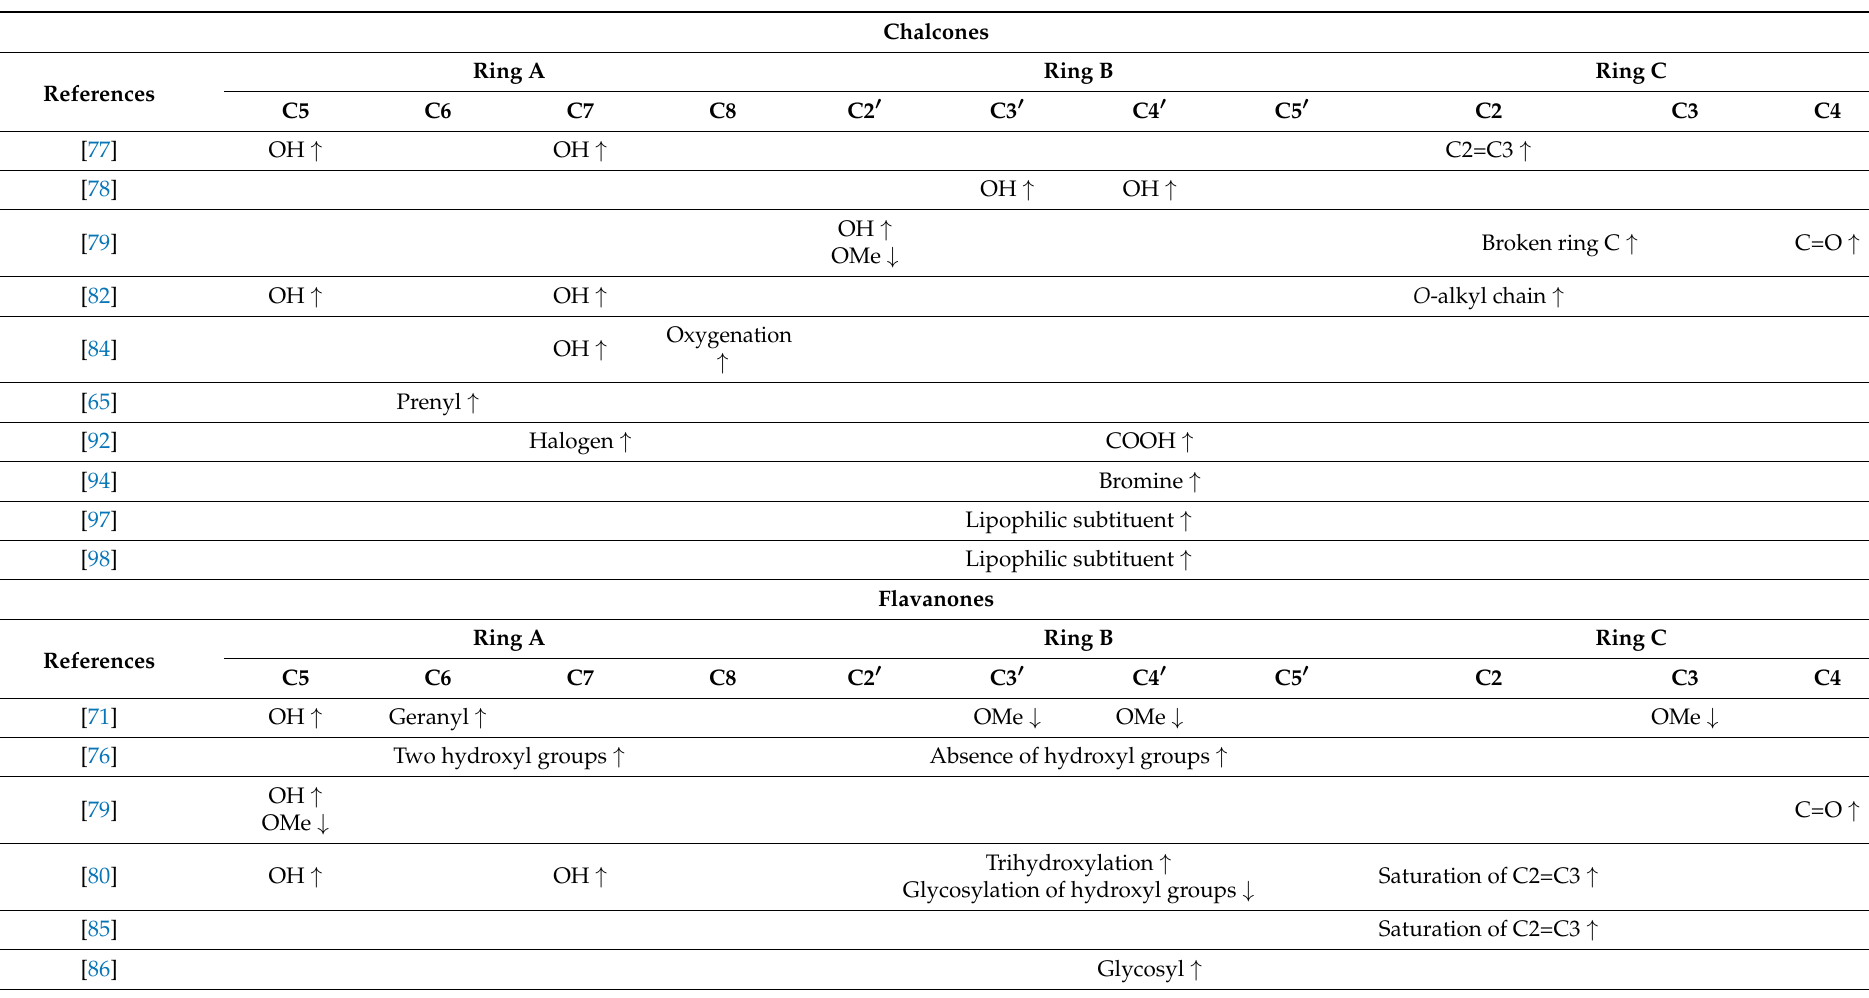
Table 23. Important structural characteristics of different classes of flavonoids for antibacterial